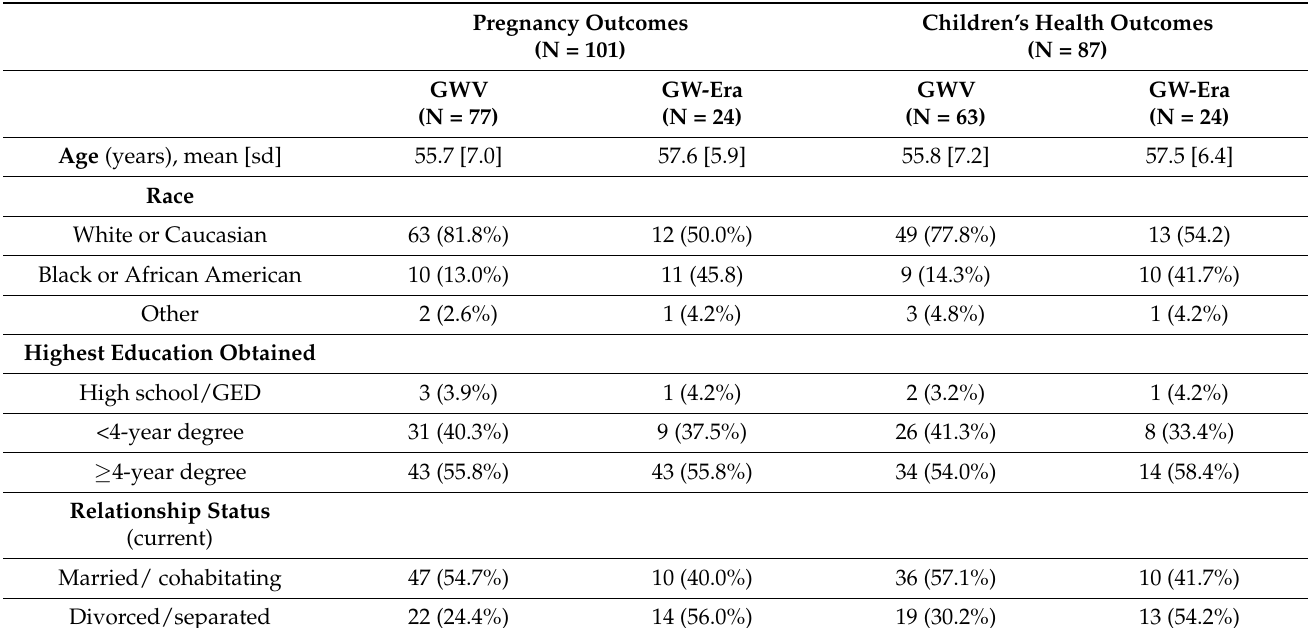
Table 1. Selected sociodemographic characteristics of women